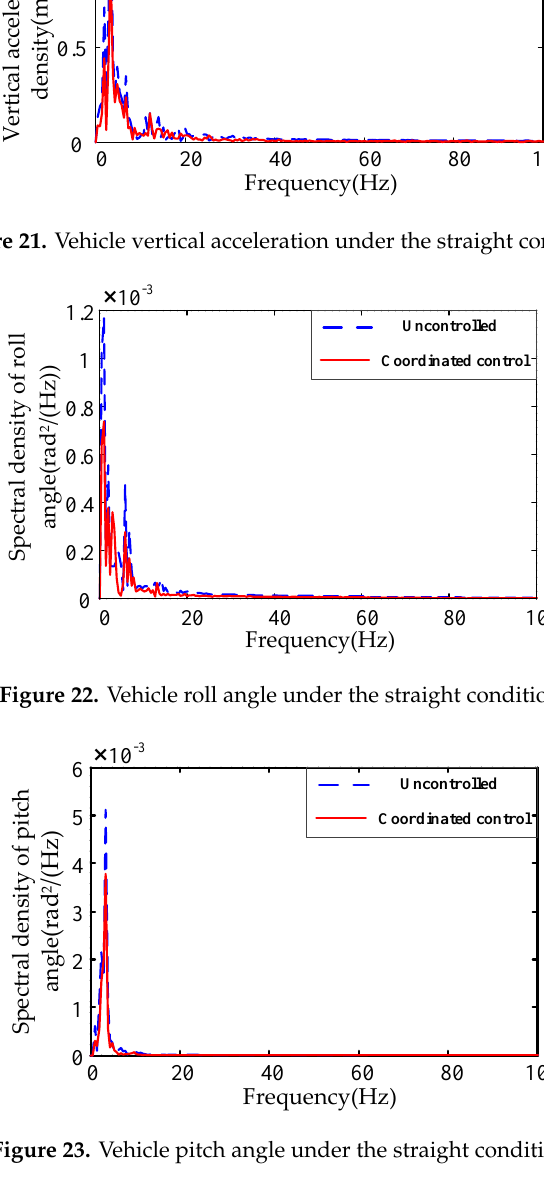
Figure 24. Dynamic stroke for front left suspension under the straight condition. Table 3. Test results of the root mean square (RMS) value of each index under the straight condition. RMS of Indicators